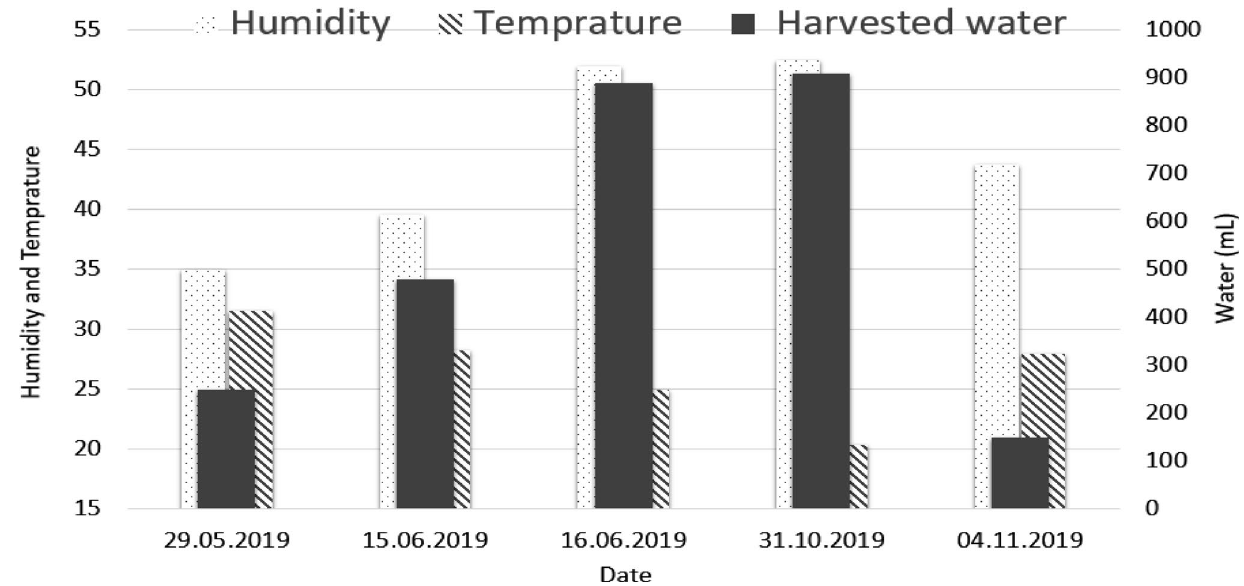
Fig. 10 Comparative representation of the parameters